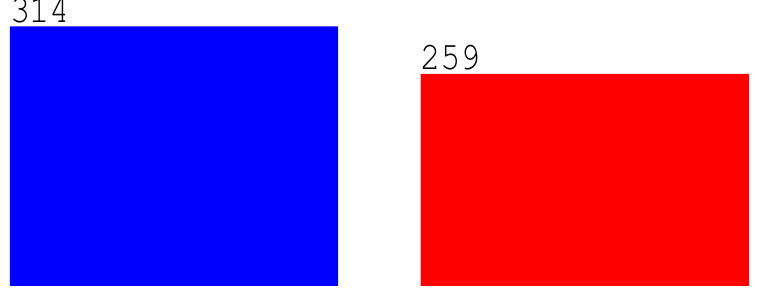
Figure 4. The target class distribution of the combined dataset. From Figure 4, the blue color bar indicates class 0 observations, i.e., absence of coronary heart disease, and the red color bar indicates class 1 observations, i.e., presence of coronary heart disease.